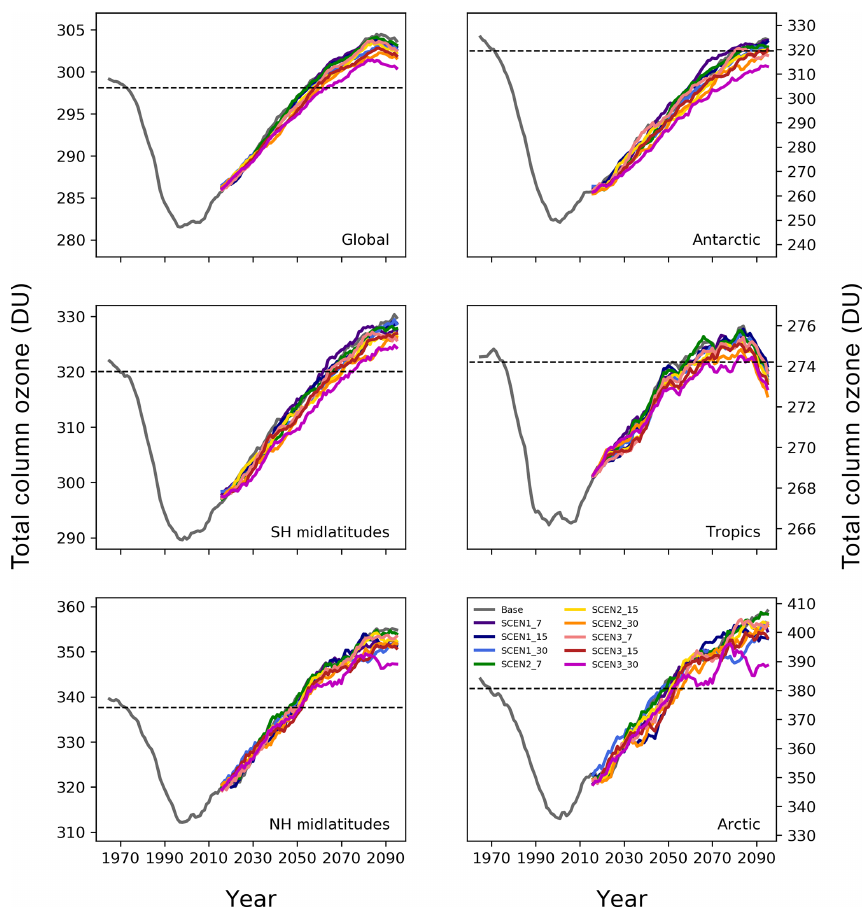
Figure 5. Smoothed TCO (in DU) for the BASE and SCEN simulations, for the global (60 ◦ S–60 ◦ N) and regional column values. Dashed line denotes the 1960–1980 baseline period, used as the value for calculating the TCO return date.